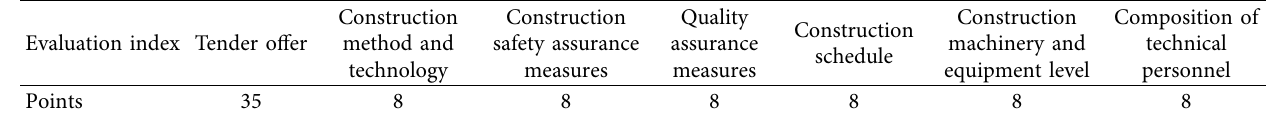
Table 2: Evaluation index and score table.